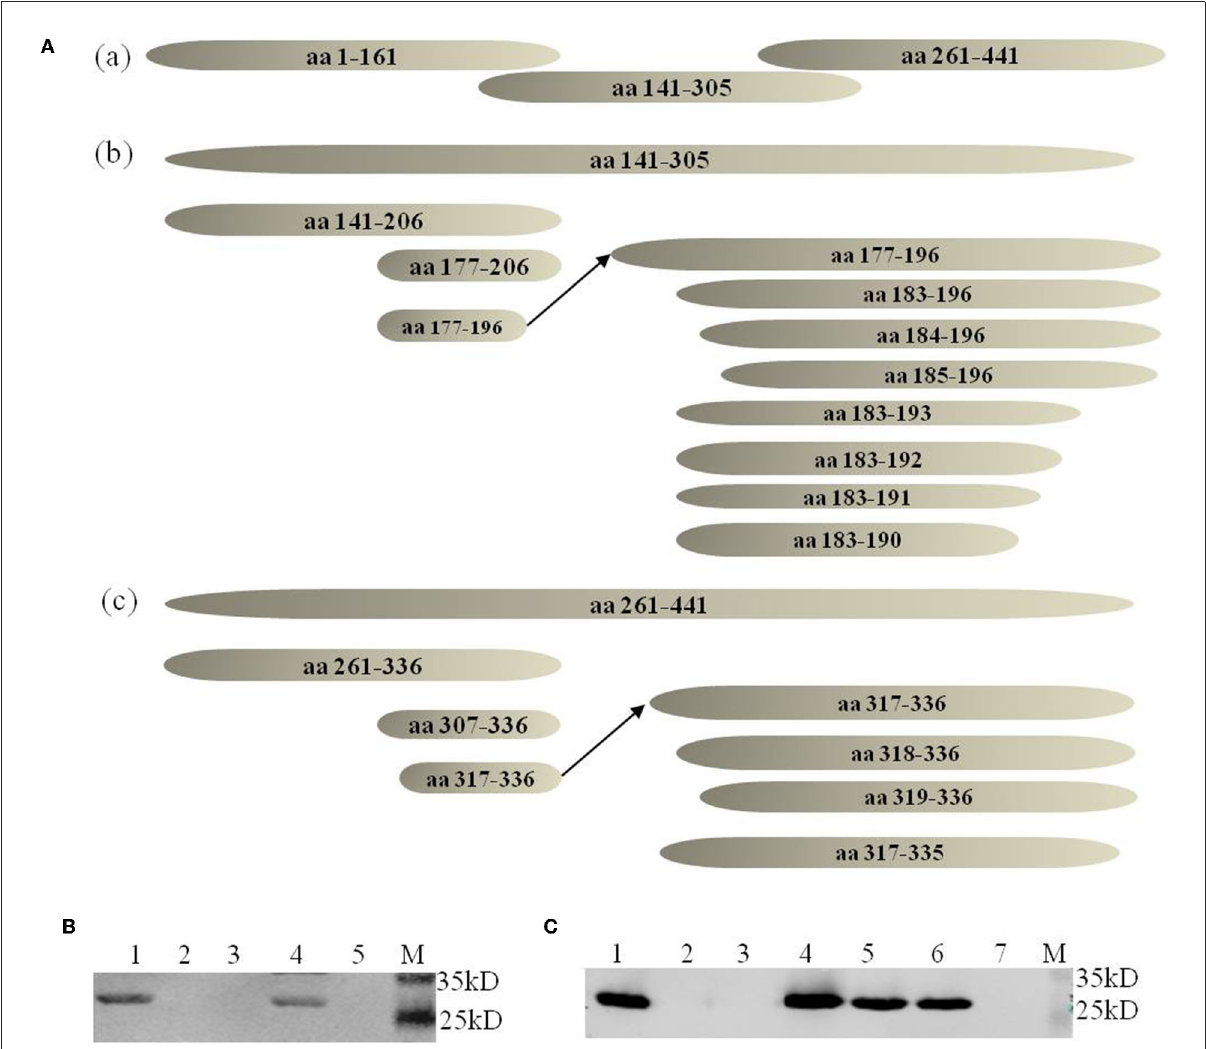
FIGURE2 Identification of antigen epitopes with MAbs 7D4 and 2-5C-6F. (A) Schematic diagrams of all peptides (not drawn to scale) used in the peptide-scanning method. (a) Three overlapping peptides spanning the VP2 aa sequences. (b) Identification of the antigen epitope with MAb 7D4. (c) Identification of the antigen epitope with the MAb 2-5C-6F. (B) Recognition of the minimal epitope with 2-5C-6F by Western blotting. Lane 1 corresponds to the epitope of aa 317-336; 2, aa 318-336; 3, aa 319-336, 4 corresponds to aa 317-336; 5, aa 317-335; M, marker. (C) Recognition of the minimal epitope with MAb 7D4 by Western blotting. 1, aa 183-196; 2, aa 184-196; 3, aa 185-196; 4, aa 183-193, 5, aa 183-192, 6, aa 183-191; 7, aa 183-190; M, marker.